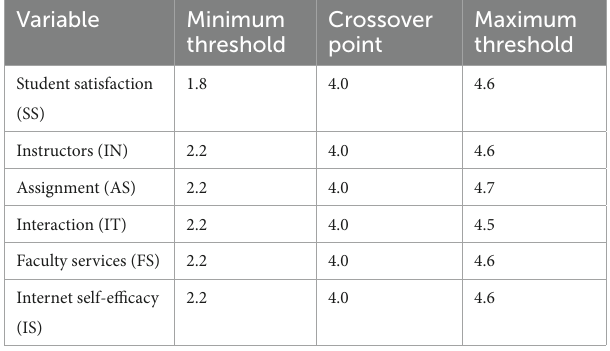
TABLE 3 Description of anchor point threshold of FuzAS